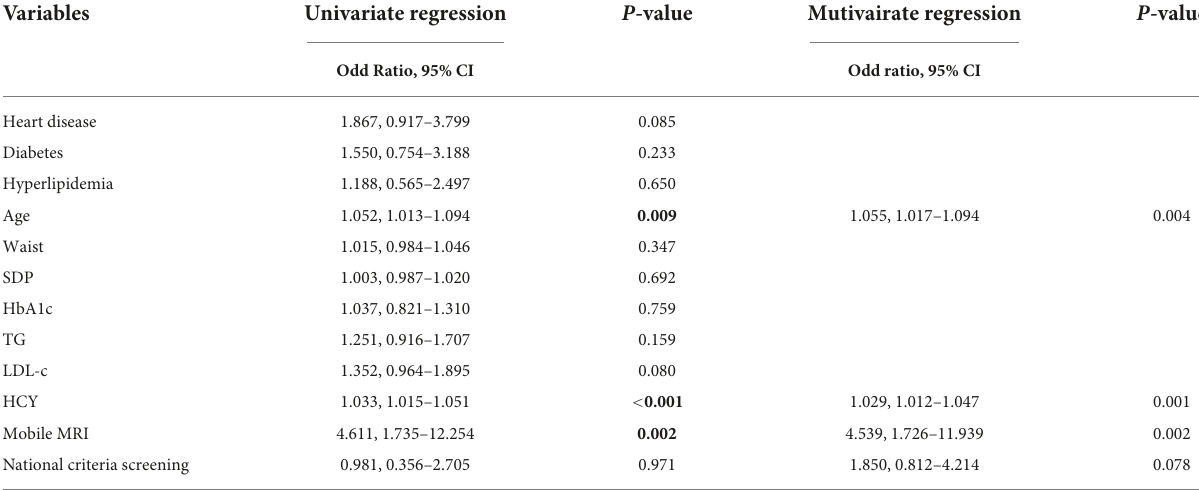
TABLE 3 Univariate and mutivairate logistic regression